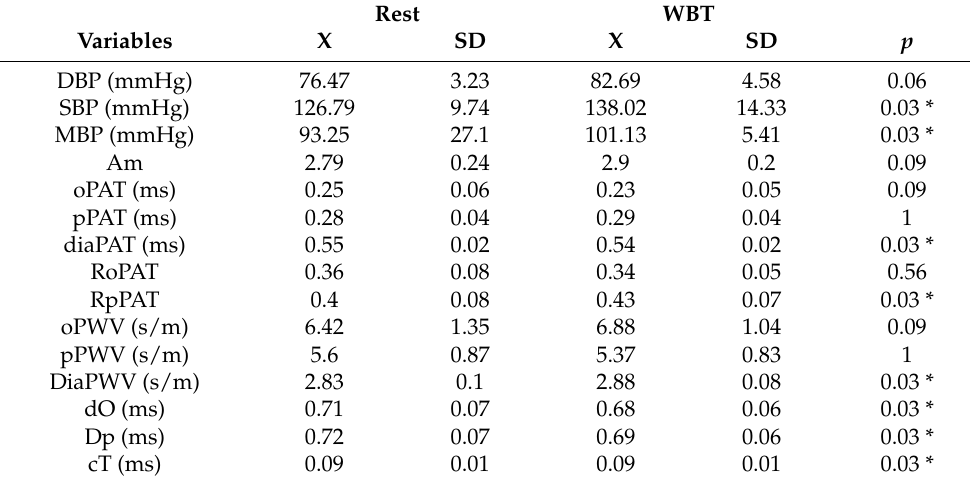
Table 1. Effect of the dynamic weight-bearing test on hemodynamic parameters. DBP, diastolic blood pressure; SBP, systolic blood pressure; MBP, mean blood pressure; AM, amplitude; Tonset, pulse arrival time onset; Tpeak, pulse arrival time peak; Tdiff, pulse arrival time maximal slope; TonsRel, relative pulse arrival time onset; TpeRel, relative pulse arrival time peak; TdiRel, relative pulse arrival time maximal slope; PWVons, pulse wave velocity from Tonset; PWVpeak, pulse wave velocity from Tpeak; PWVdiff; pulse wave velocity from maximal slope; cT, crest time; X, mean; SD standard deviation. * Statistically significant difference at p <